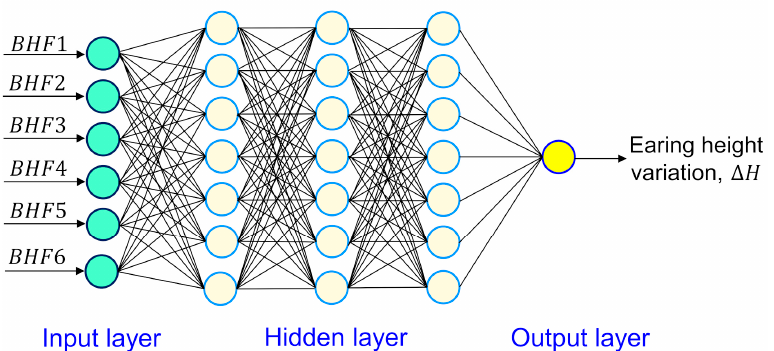
Figure 7. Deep neural network (DNN) architecture for the prediction of earing height variation, Δ H (mm).